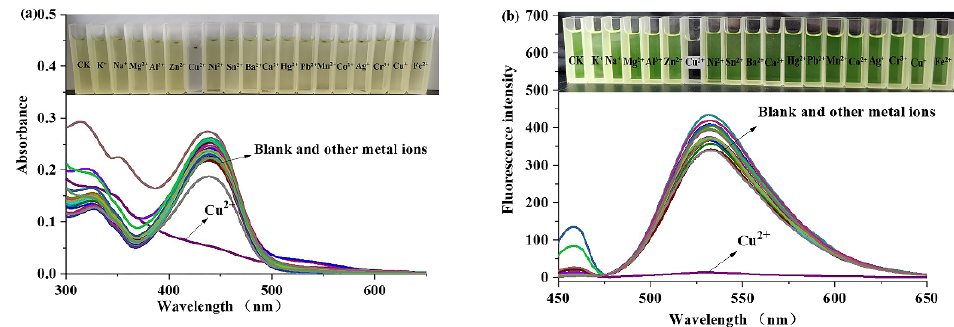
Figure 1. UV–vis ( a ) and fluorescence ( b ) spectra of NPA toward various metal cations.